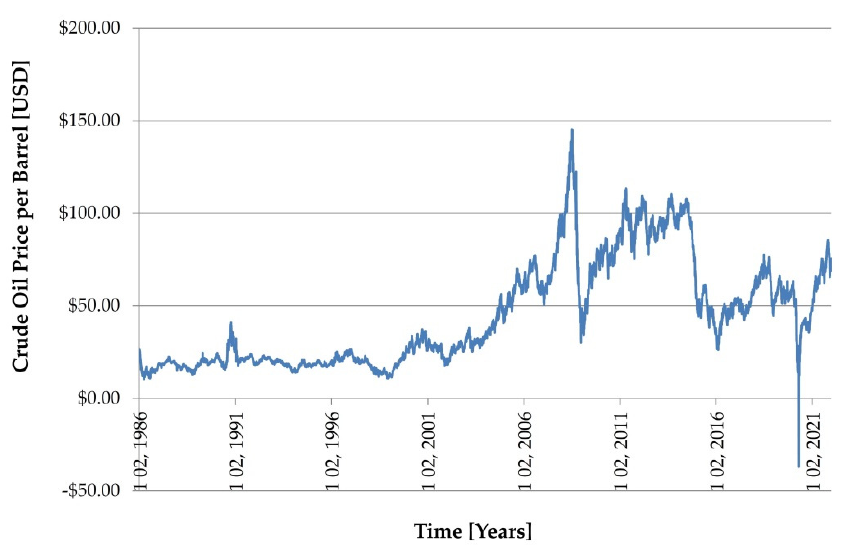
Figure 2. The crude oil prices per barrel back to 1986 based on open data from U.S. Energy Information Administration [32].